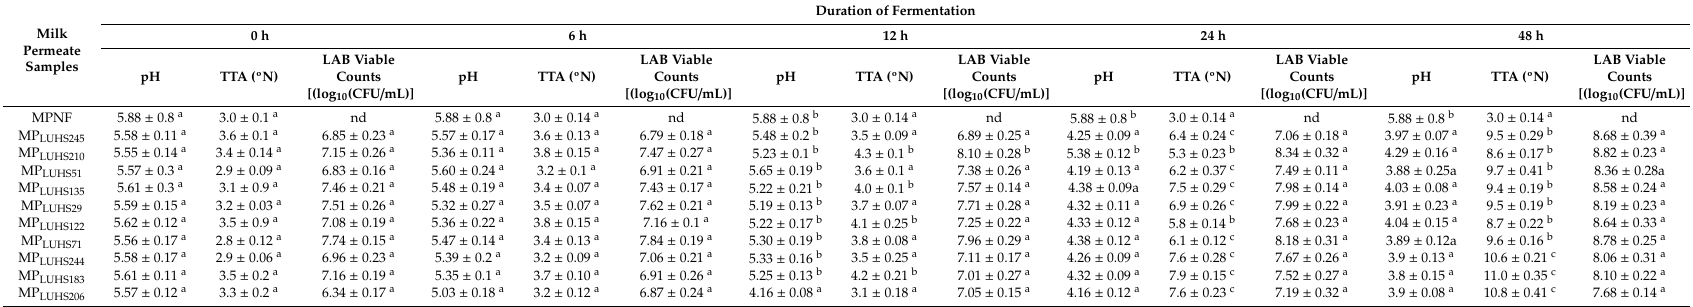
Table 1. Average values and standard deviations (Mean ± STDV) ( n = 3) of the acidity parameters, pH and total titratable acidity (TTA), and total lactic acid bacteria (LAB) viable counts in the milk permeate (MP) samples throughout fermentation (t sampling = 0, 6, 12, 24, 48 h). Milk